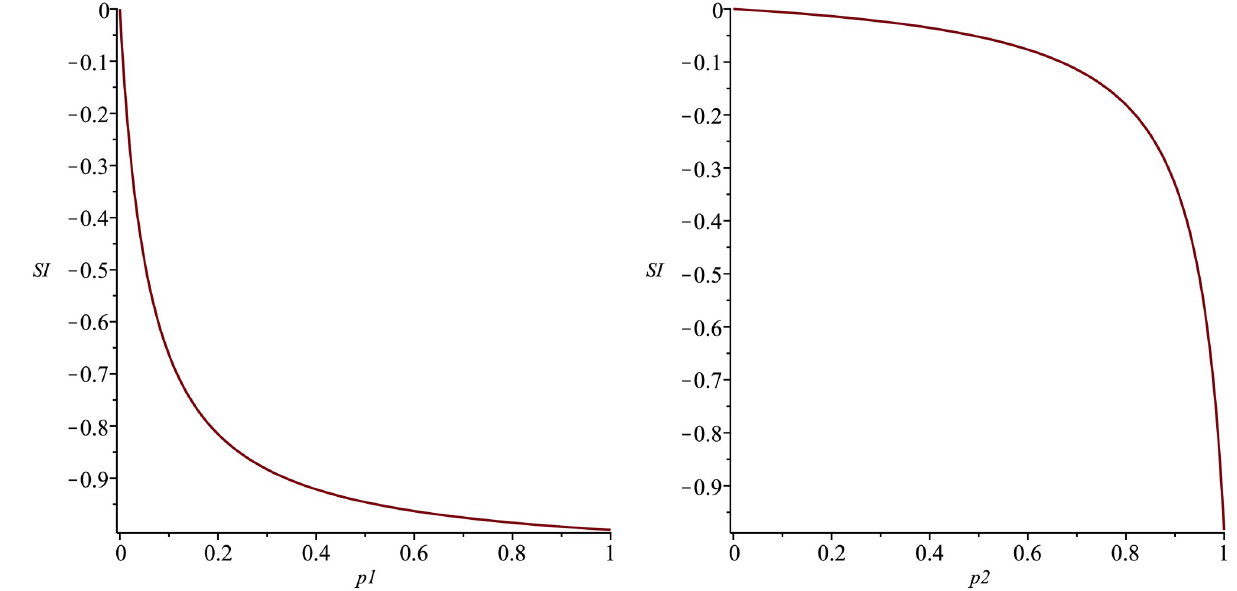
Fig 5. Sensitivity indexes Ω R 0